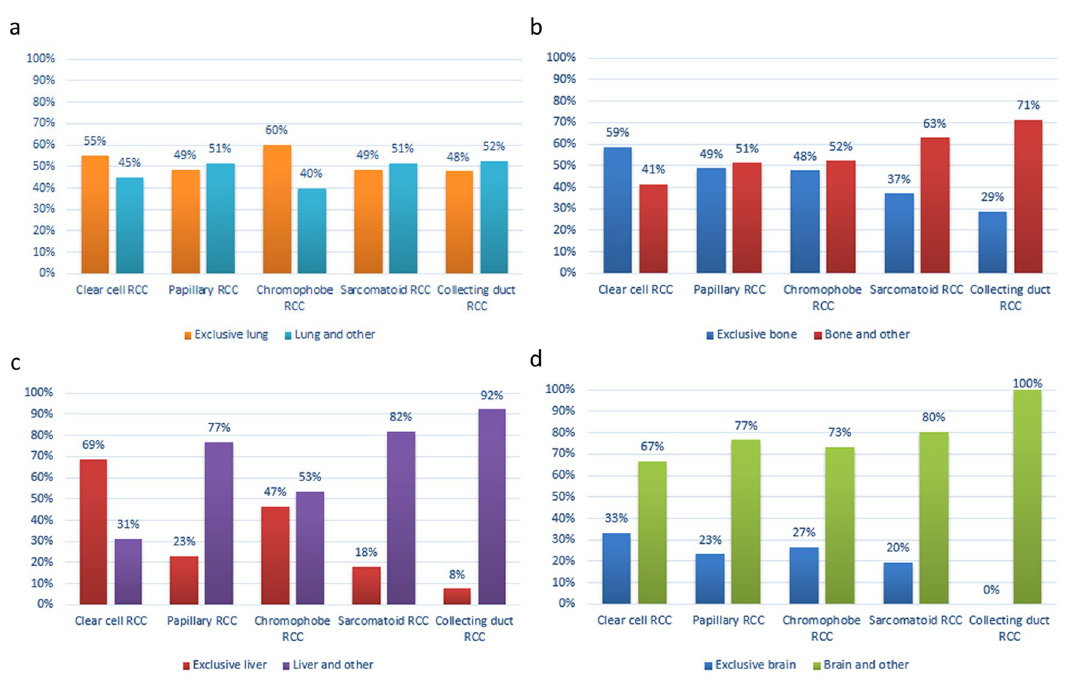
Figure 2. The distribution of metastases in a single versus multiple concomitant sites, stratified by pathology categories, in the four kinds of metastatic sites: lung ( a ), bone ( b ), liver ( c ), and brain ( d